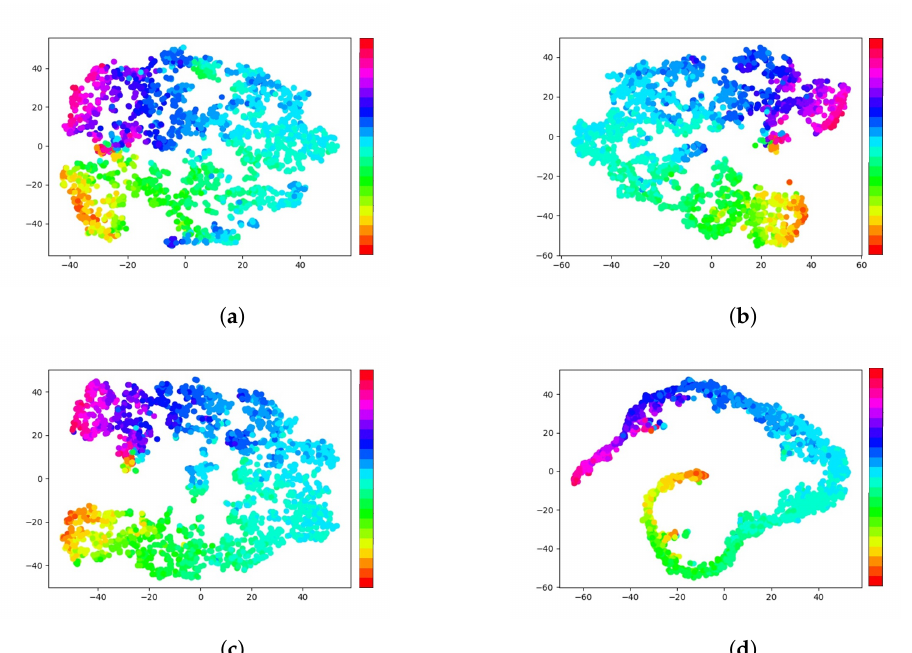
Figure 6. The tSNE visualization of the extracted features from the different paradigm models. The samples were divided into several bins with different colors, according to their yaw angles: ( a ) w/o ca; ( b ) w ca; ( c ) cas ce; ( d ) hybrid.